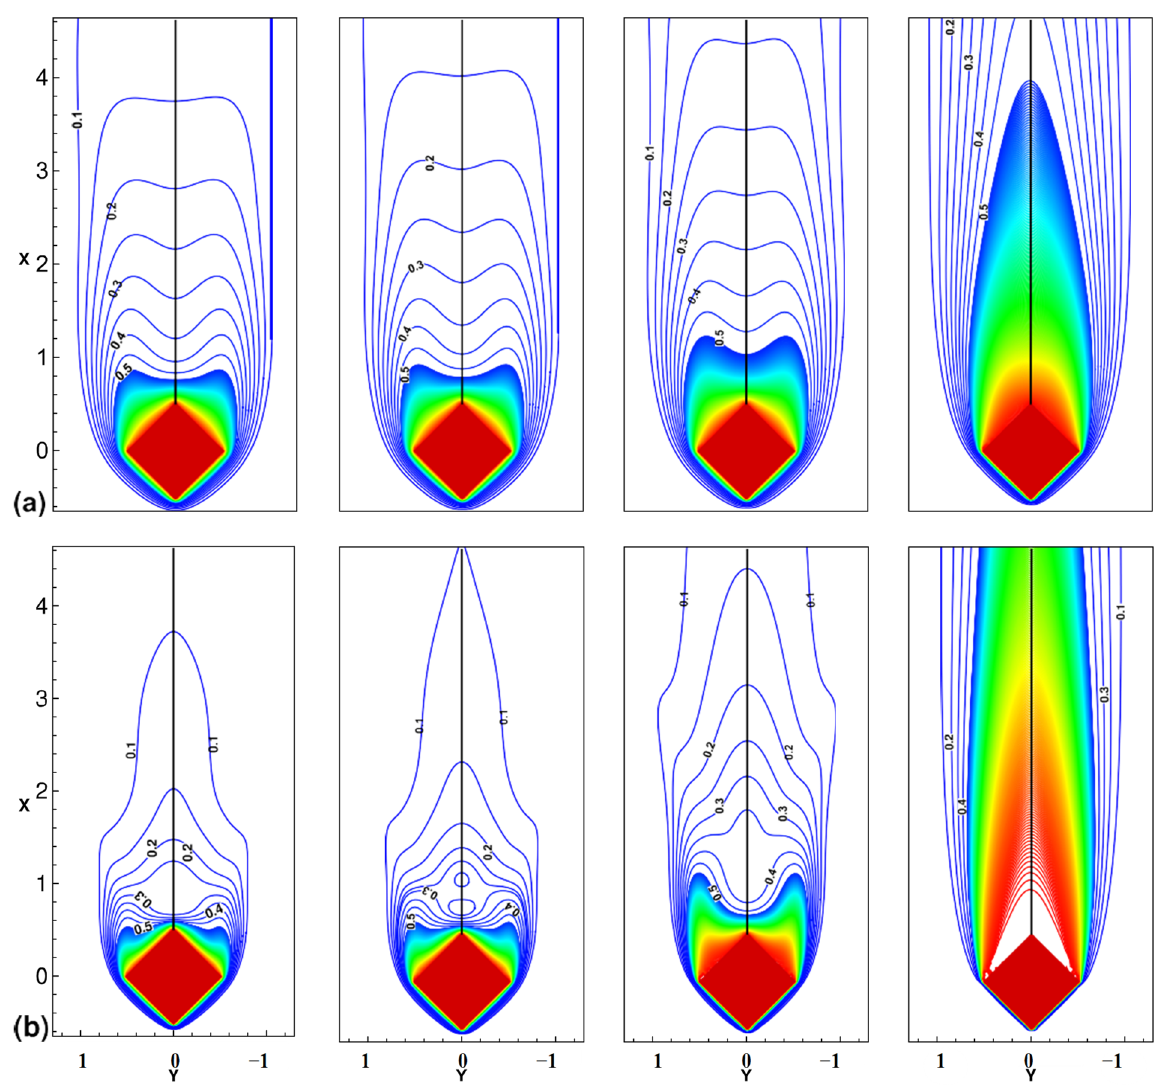
Figure 21. Time-averaged isotherm contours of mean flow around and through a permeable diamond-shaped cylinder at: ( a ) Re = 50 and ( b ) Re = 150 for various Darcy numbers [167], reprinted/adapted with permission from Ref. [167], 2022, Elsevier.